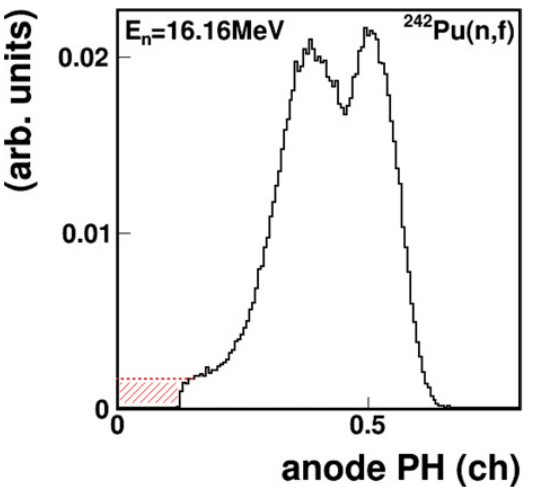
Figure 3. Anode pulse height (PH) distribution for 242 Pu(n,f) with the determination of the counts under the electronic threshold at E n = 16.16 MeV.